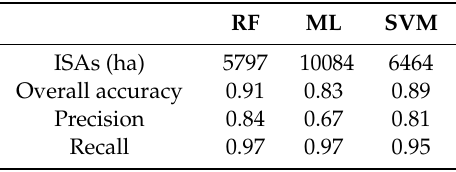
Table A1. A comparison of di ff erent